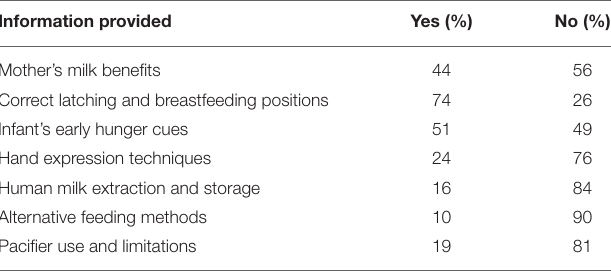
TABLE 4 | Answers to item 4 of the breastfeeding questionnaire: information provided by healthcare staff during hospital stay. Information provided